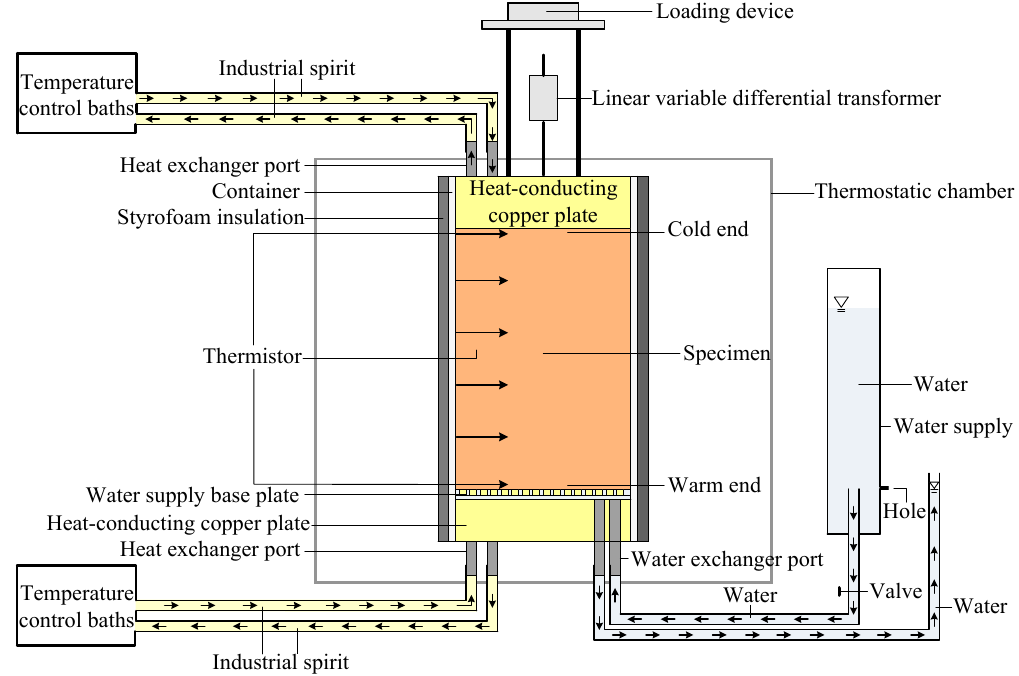
Figure 2. Schematic diagram of the freezing experiment apparatus.